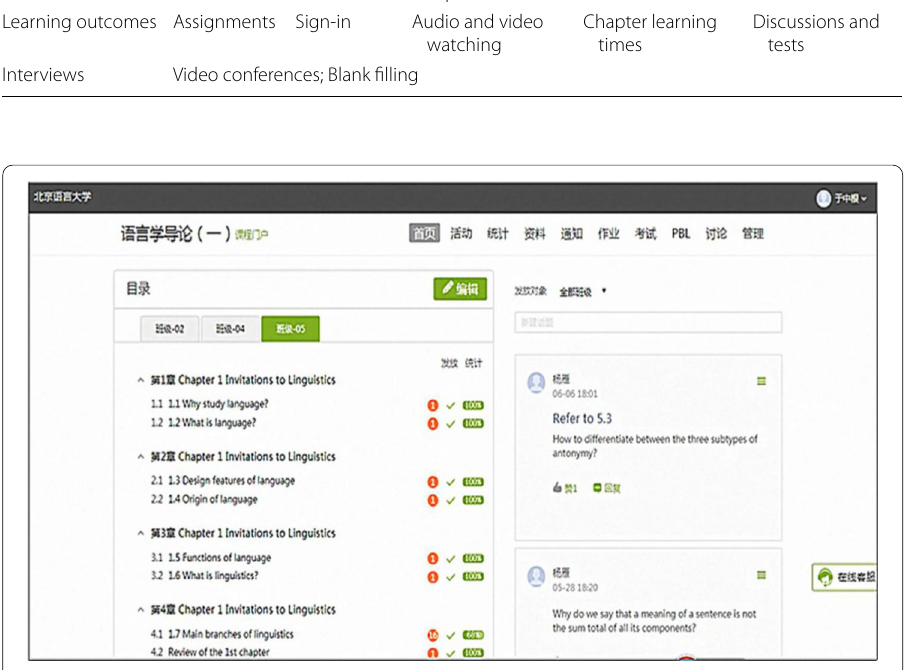
Fig. 1 BLCU MOOCs of the course “An Introduction to